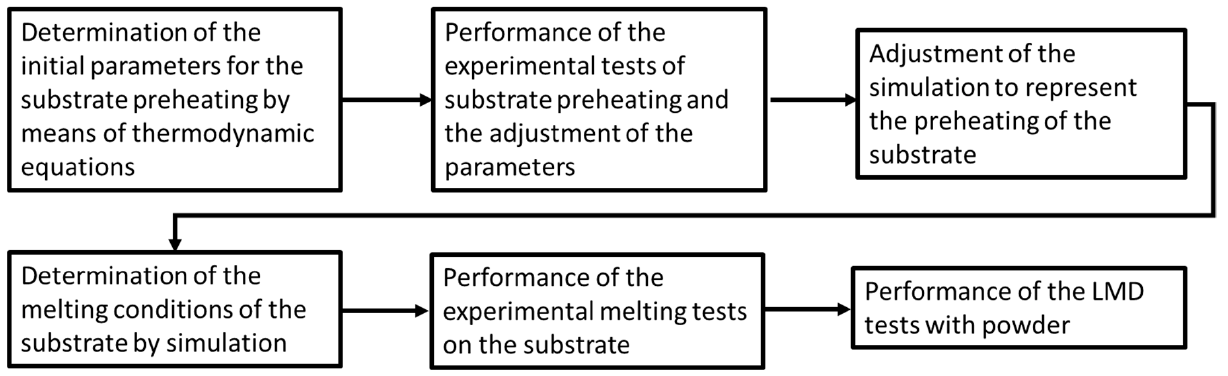
Figure 1. Summary of the developed methodology.